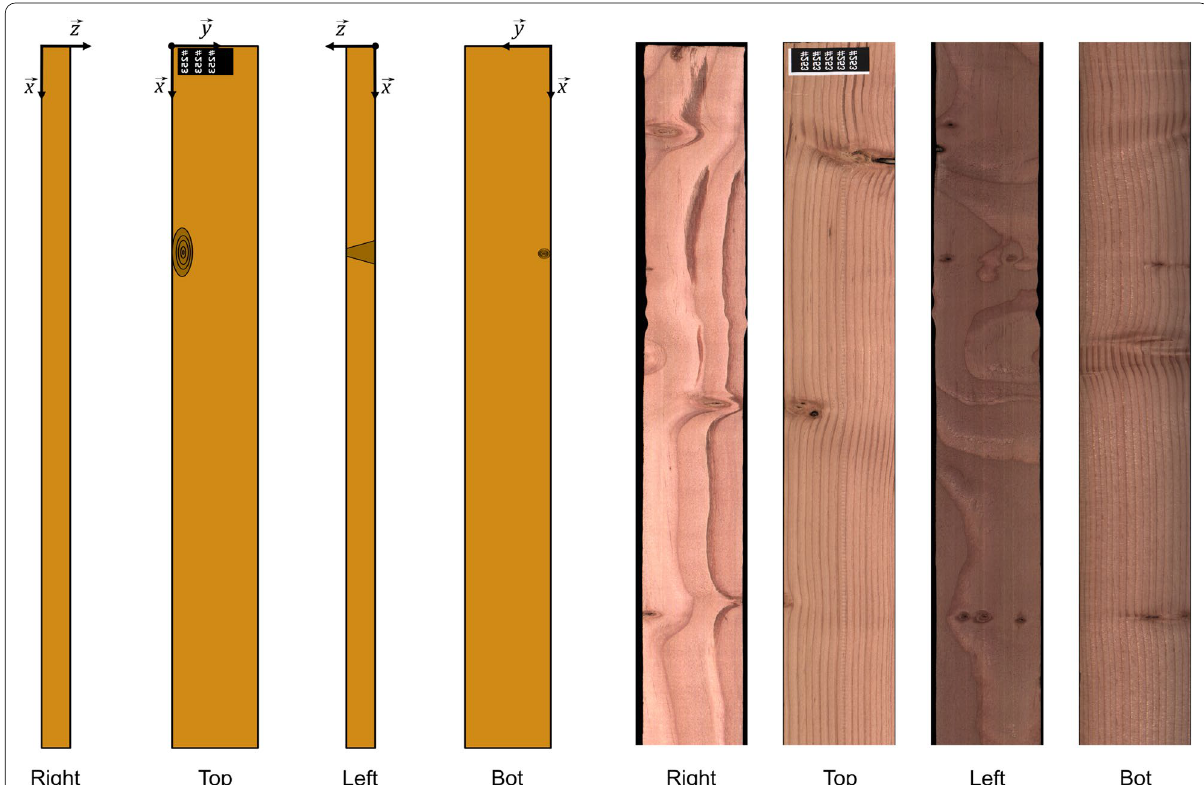
Fig. 10 To the left: Illustration of the images that are obtained when scanning the four side faces of the board example of Fig. 7. The board coordinate system is shown on it, highlighting the need to flip the image if one want to make a three‑dimensional representation. To the right: actual RGB images obtained on a portion of board #253. Note that the resolution is not squared and different between large and narrow faces, which induces a different aspect ratio than in